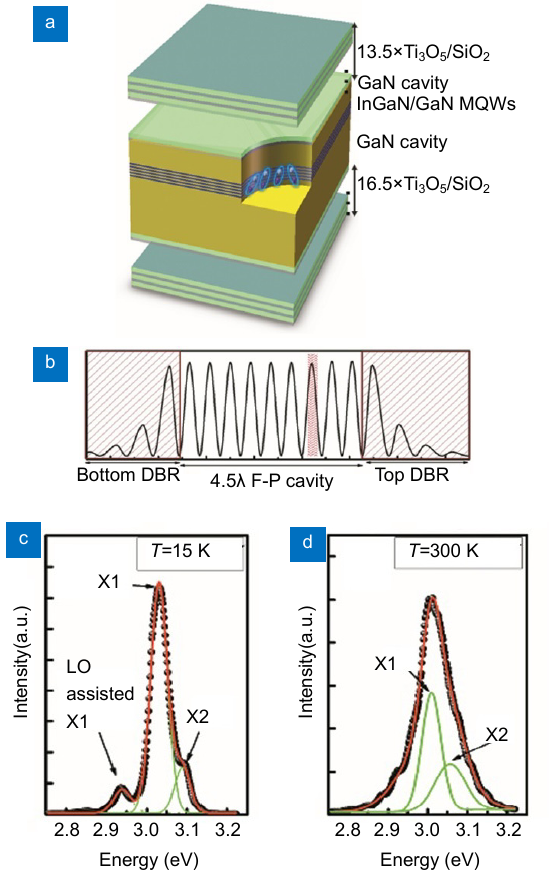
Fig. 1 | ( a ) Sample structure of InGaN/GaN MQWs microcavity for strong coupling. ( b ) The optical field in the microcavity with MQWs placed on the antinode. ( c ) and ( d ) Photoluminescence spectrums of bare wafer at 15 K and 300